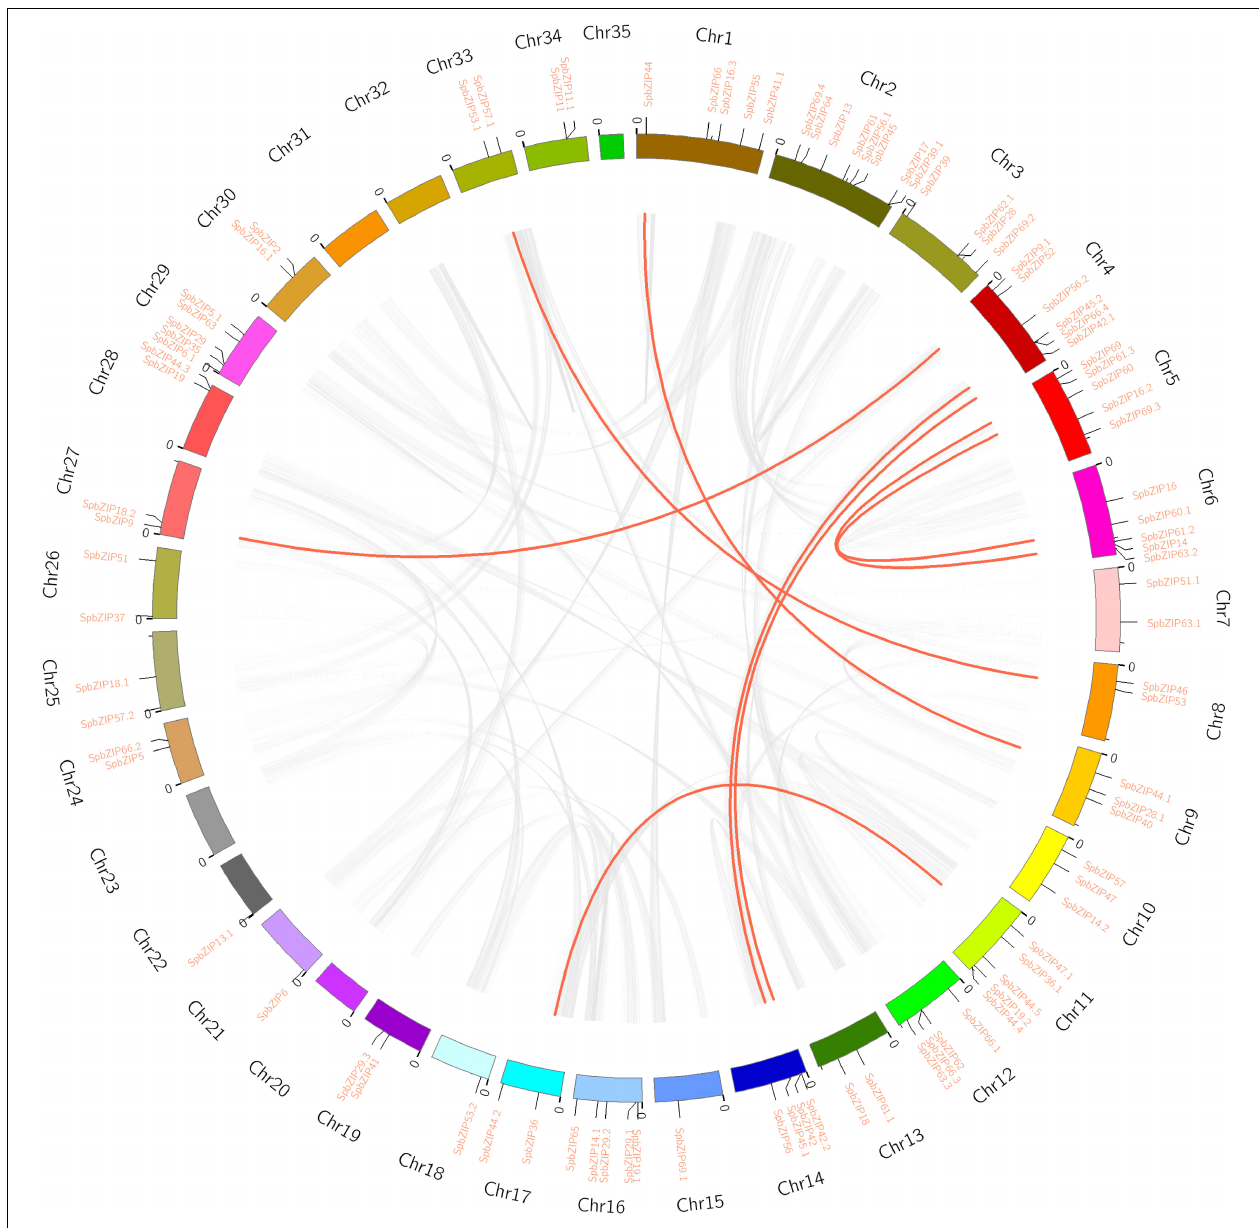
FIGURE 3 | Genome location and synteny of bZIP genes in S. plumbizincicola . Gray lines indicate syntenic blocks in the S. plumbizincicola genome, whereas the red lines between chromosomes indicate segmentally duplicated gene